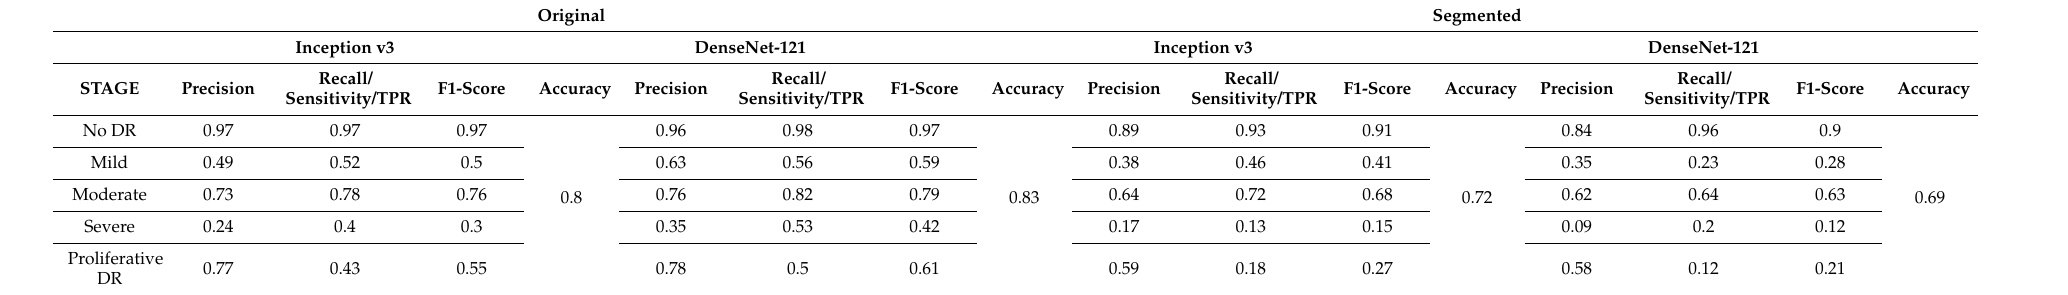
Table 3. Test performance for original and segmented blood